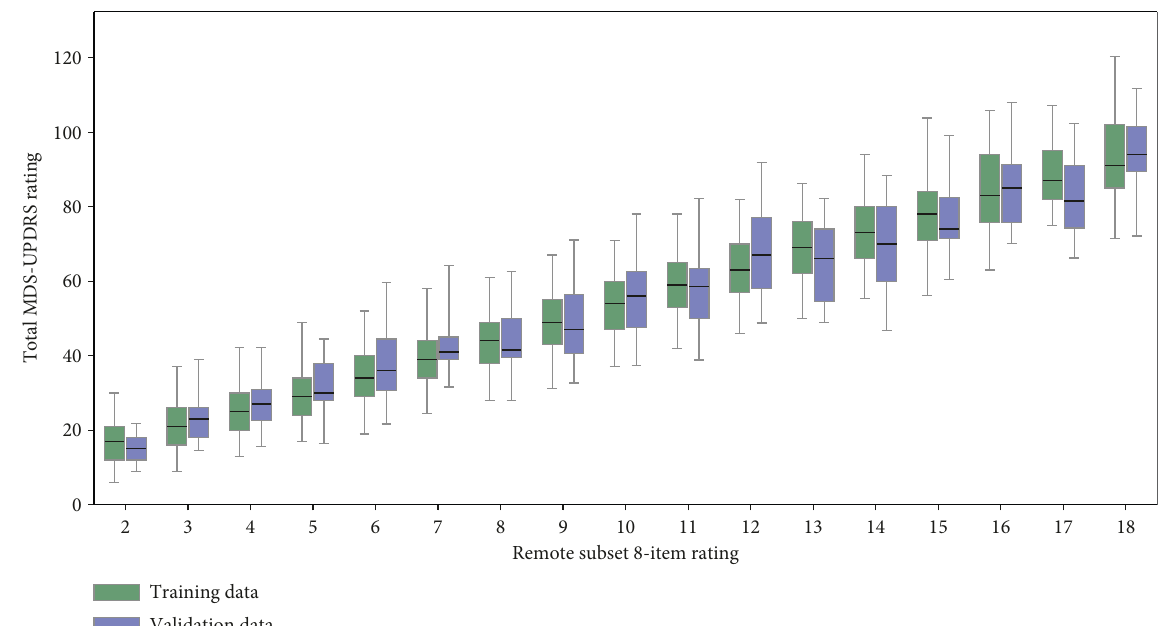
Figure 1: Boxplots showing the distribution of the sum rating of the total 50-item MDS-UPDRS rating for each value of the remote subset rating (see Table 1) for both training and validation datasets, with the interquartile range indicated by the boxes and the range from the 2.5th to 97.5th percentile indicated by the whiskers. Note this figure only displays boxplots of 8-item ratings for which n ≥ 5, e.g., 8-item rating of zero is not displayed because n ≥ 5 in the validation dataset (Supplement Table 8 shows the ( n ) for each rating). For each of these ratings, there is a large overlap between the range from 2.5th to 97.5th percentile of the training and validation